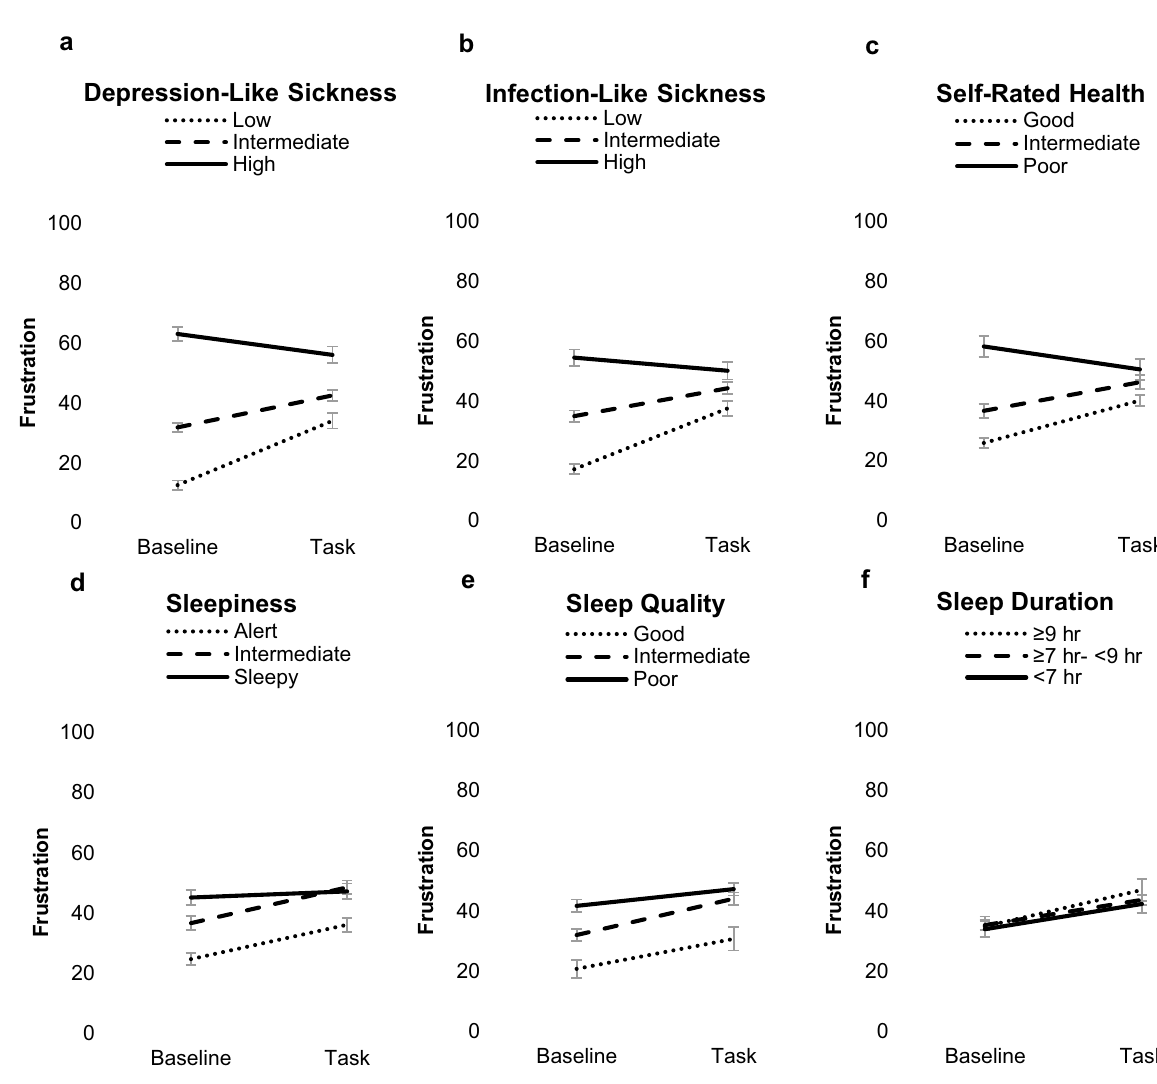
Figure 2. Frustration levels (means and SEM) at baseline and during the Frustration Tolerance Task , for the groups with low, intermediate, and high levels of sickness ( a – c ) and sleep health stressors ( d – f ) (the sleep duration groups was divided into short-, intermediate- and long